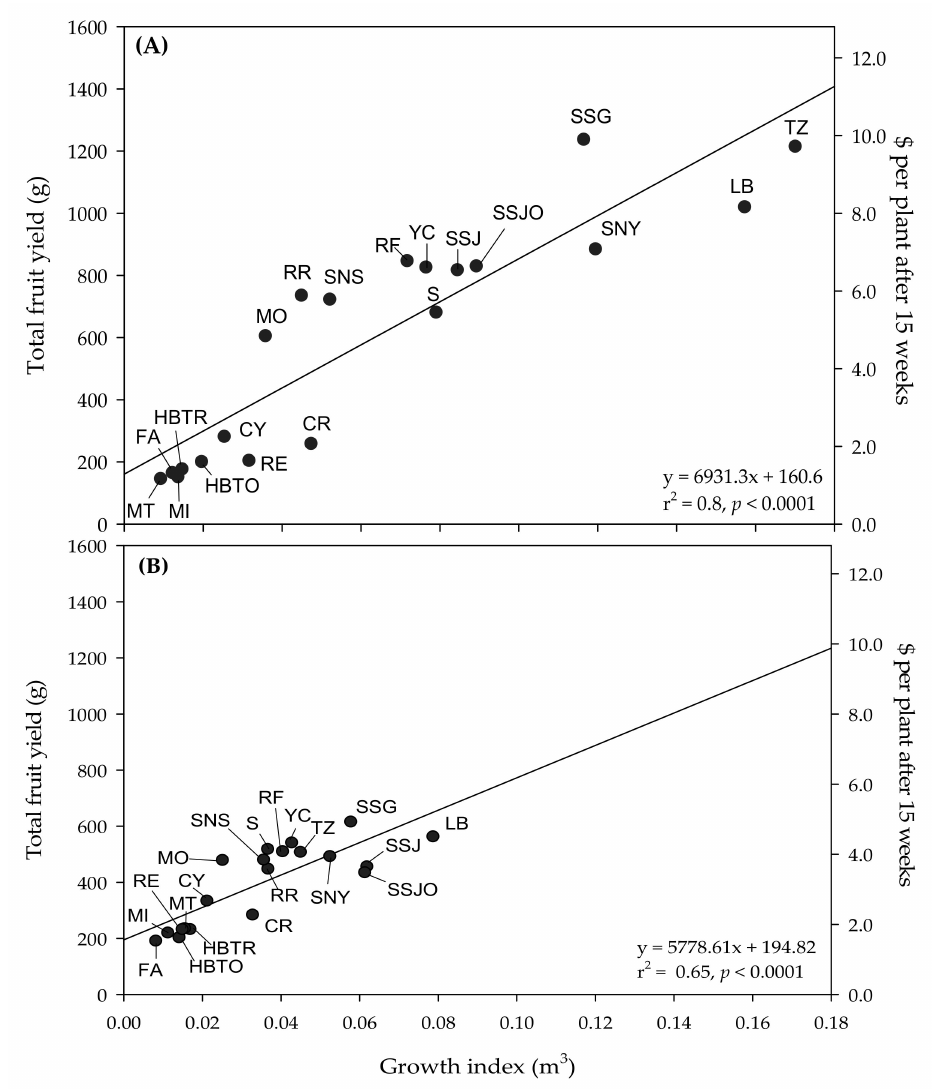
Figure 2. Effect of growth index on total fruit fresh mass produced by compact tomato cultivars grown in a greenhouse ( A ) or indoors ( B ), and average retail price of cherry tomatoes (adapted from the USDA [20]). Data were collected from the average of eight replicates per cultivar from the second experimental run. Growth index was calculated using the formula π × h × r 2 , where h is shoot height and r is calculated by multiplying 1 times the mean of two leaf widths. Cultivar names are detailed 2 in Table